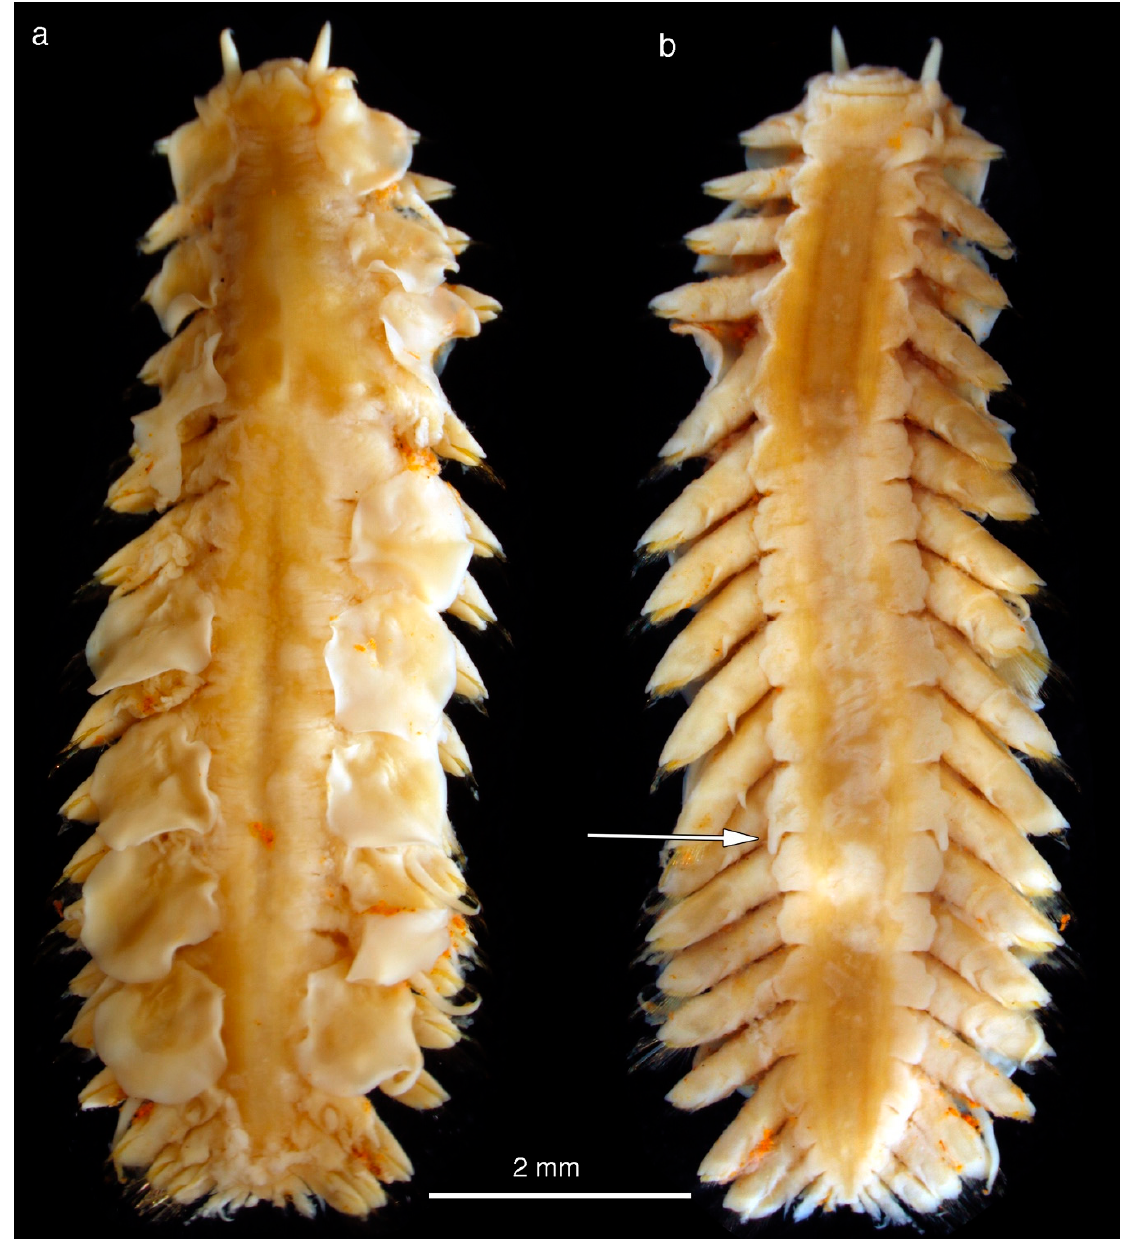
Figure 18. Branchipolynoe tjiasmantoi n. sp. preserved male paratype (SIO-BIC A7303A). ( a ) Dorsal view. ( b ) Ventral view. Arrow indicates one of the paired elongated ventral papillae on segment 12.